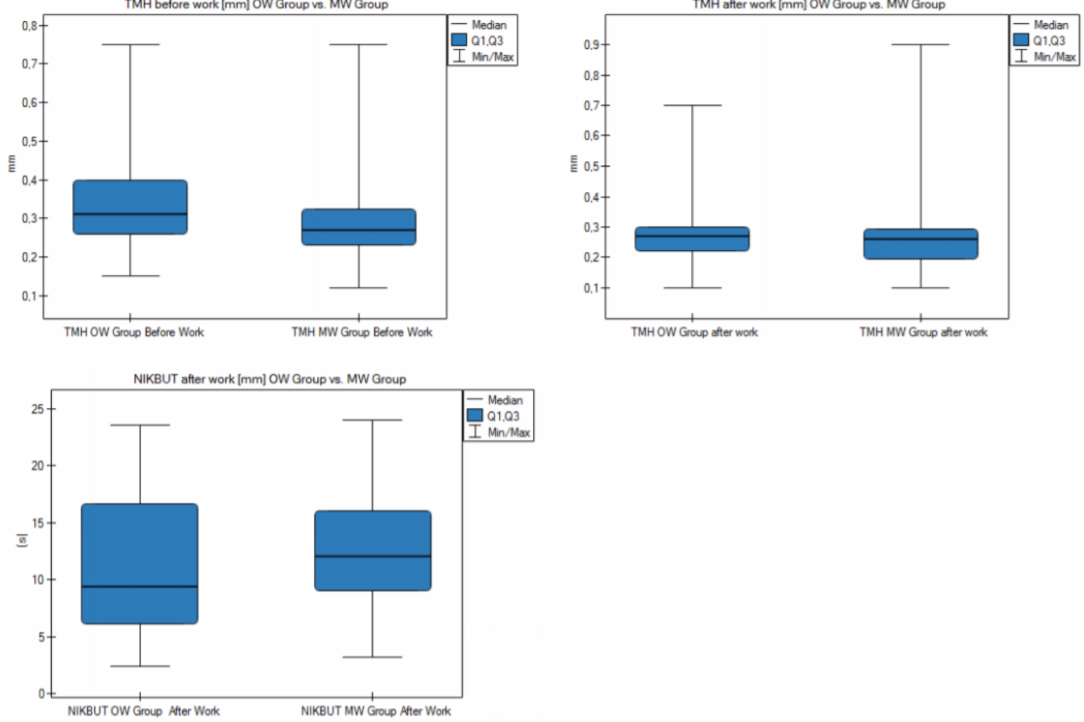
Figure 2. Comparison of the measurement results of the eye surface parameters in the OW and MW